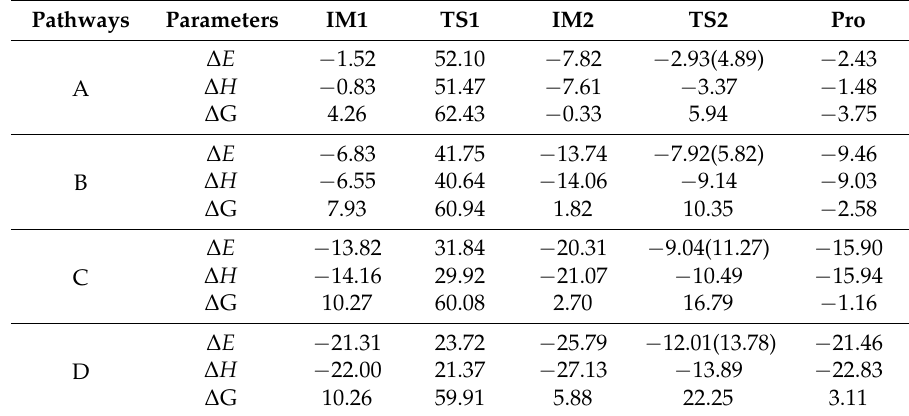
Table 2. Calculated relative energy ( ∆ E ), enthalpy changes ( ∆ H ), and Gibbs free energy changes ( ∆ G ) for the available intermediates, transition states, and products relative to the isolated reactants in the different reaction pathways involving neutral H 2 O 2 a